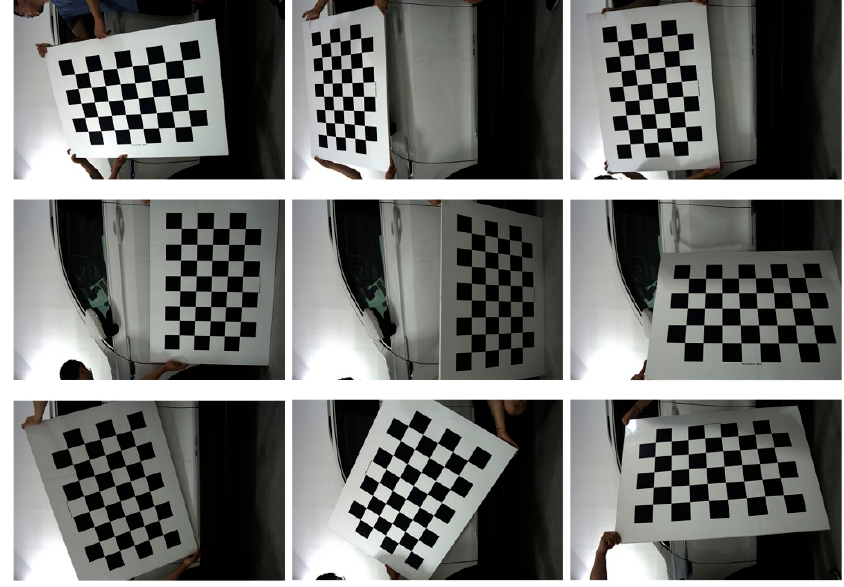
Figure 8. Camera calibration using a 6 × 9 × 100 mm 3 chessboard.